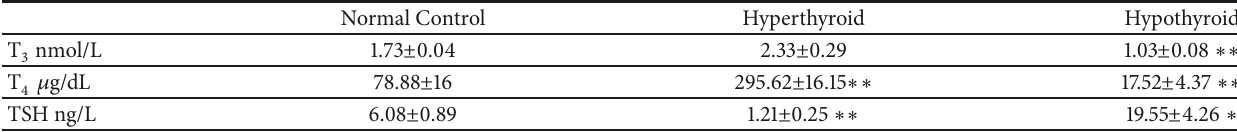
Table 1: Mean and SE (standard error) of serum levels of T 3 (tri-iodothyronine), T 4 (thyroxine), and TSH (thyroid stimulating hormone) in normal, hyperthyroid, and hypothyroid rats.